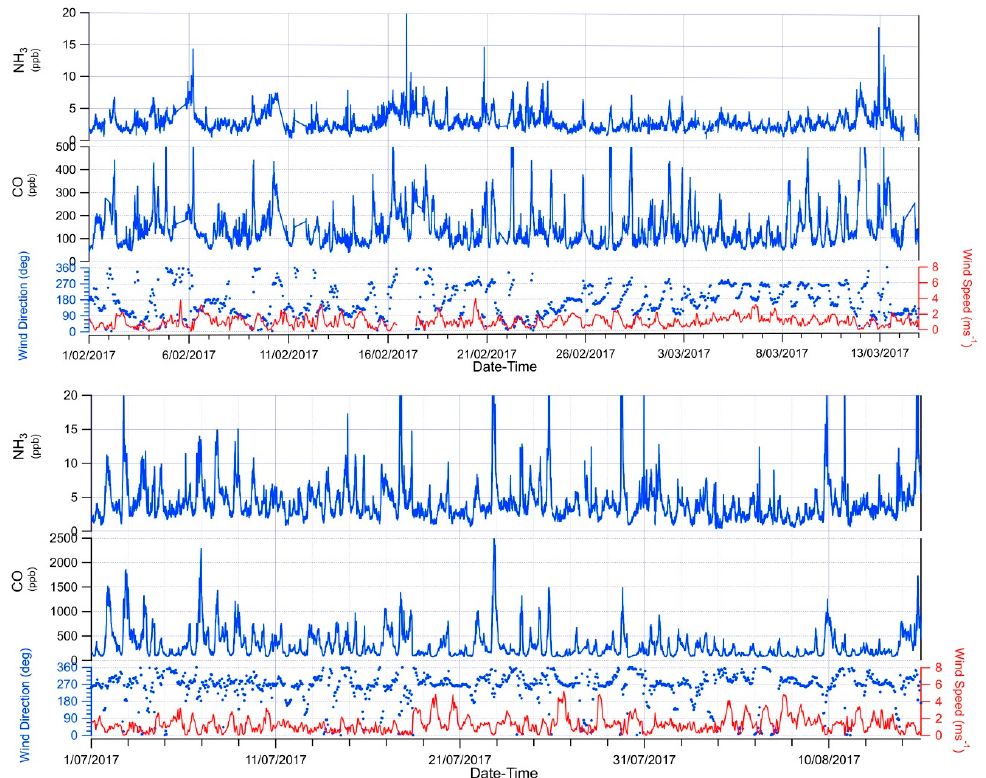
Figure A3. Time series of CO and NH 3 measured by the OP-FTIR system during summer (top panel) and winter (lower panel) in Western Sydney. Note the higher levels of CO and NH 3 measured in winter compared to summer. Wind speed (m s − 1 ) and wind direction are included in the lower panel of each plot.